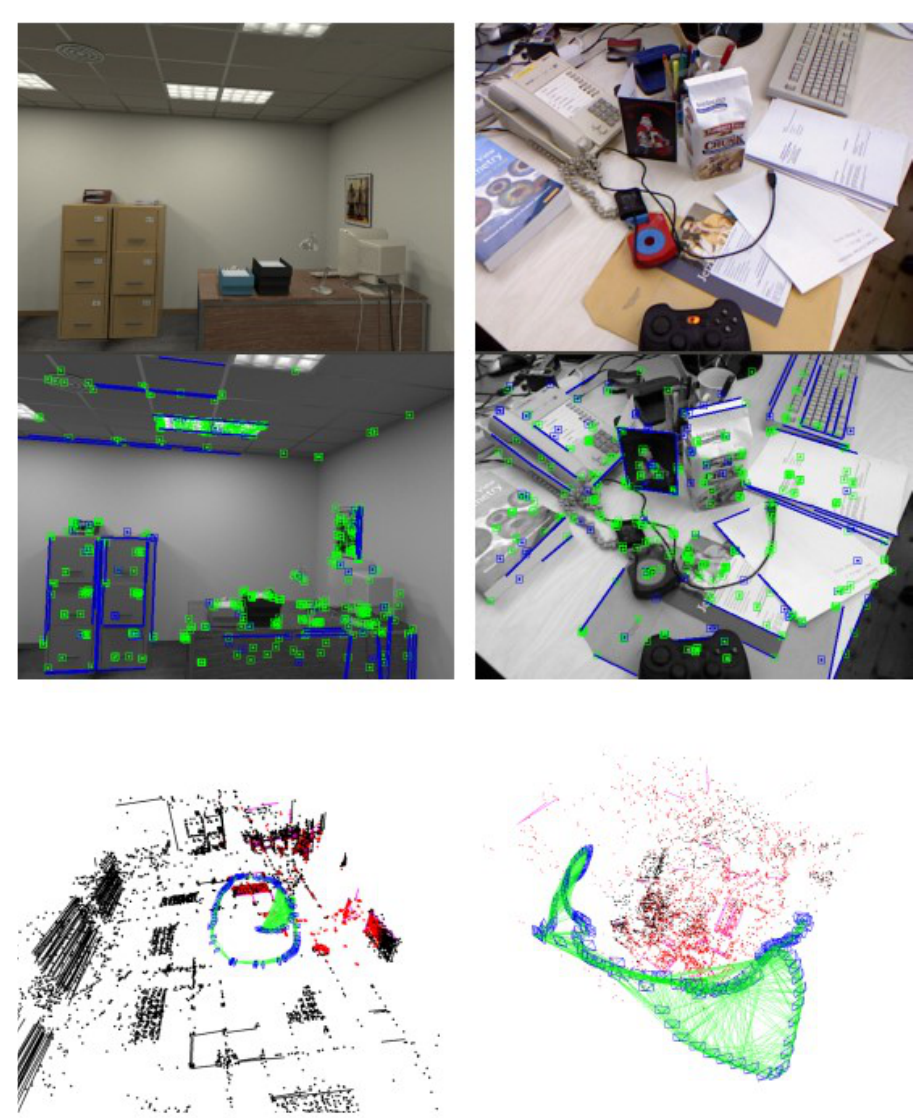
Figure 1. The proposed RGB-D VO system. Top Left : Structured scene. Top Right : Cluttered scene. Bottom Left : Sparse map in a structured scene. Bottom Right : Sparse map in a cluttered scene.